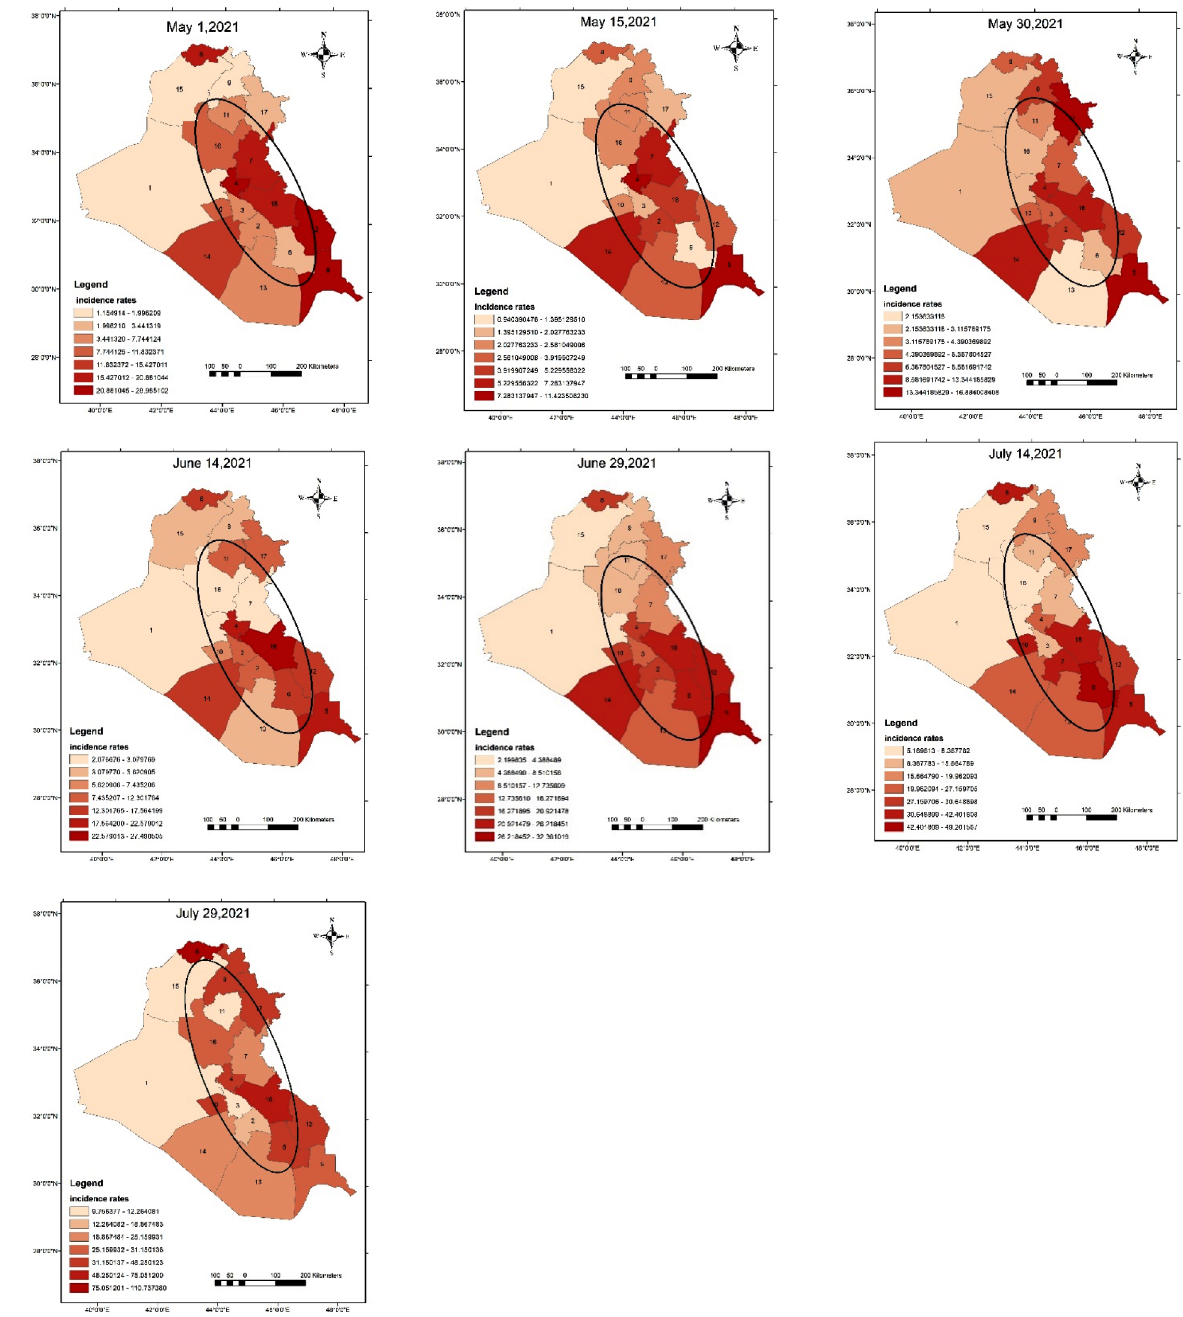
Figure 5. The distribution of COVID-19 infected Iraqi governorates, on May 1, May 15, May 29, June 14, June 29, July 14, July 29